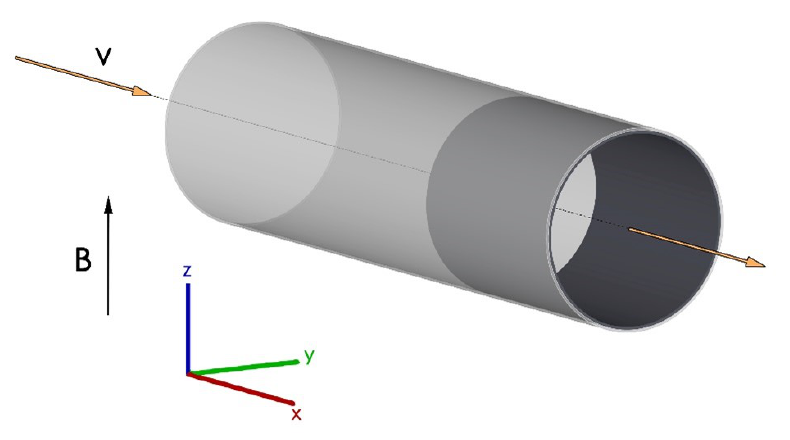
Figure 4. 3D sketch of the experimental section. The darker portion of the pipe is where insulation is applied (FCI). Magnetic field vector B and velocity v are depicted.